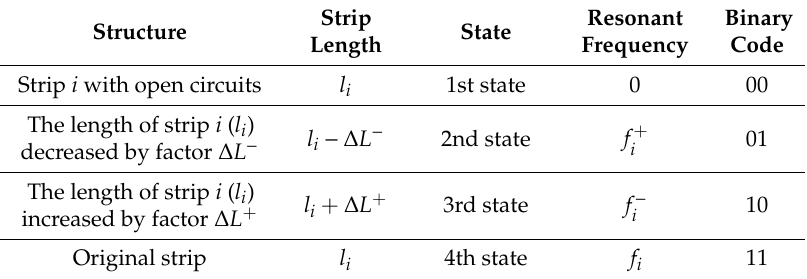
Table 3. Possible states for a single overturned M-shaped